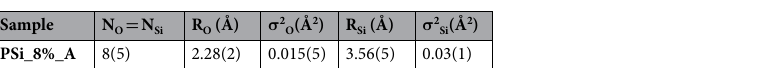
Table 2. Results of the quantitative EXAFS analysis. The errors on the last figure are indicated in